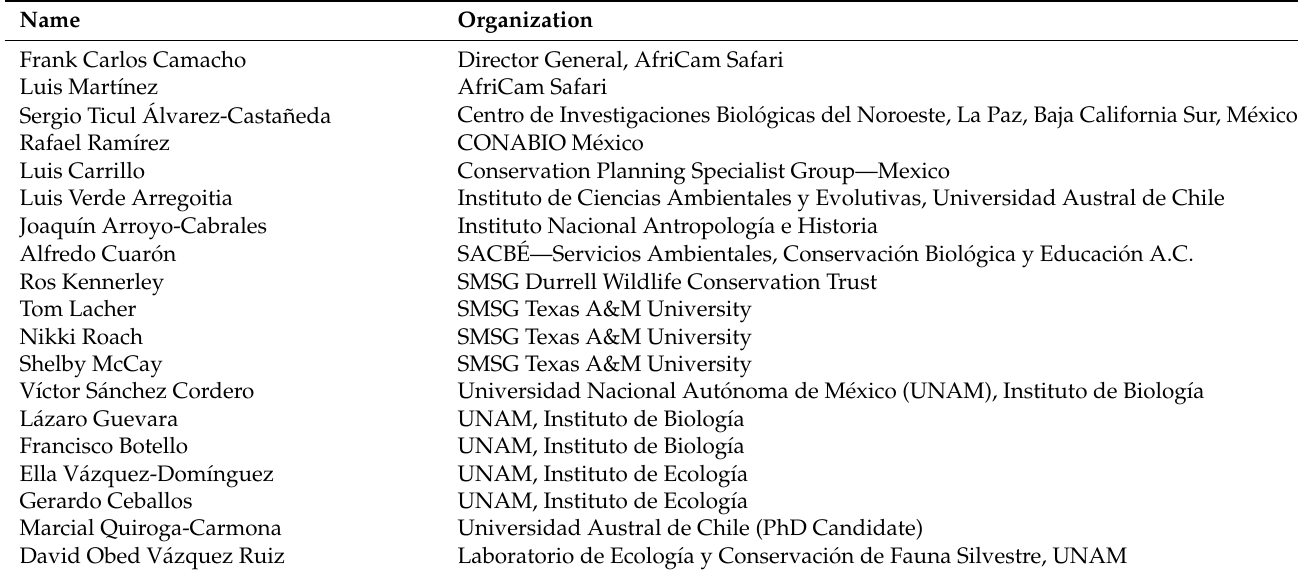
Table A1. Participants in SMSG Mexico workshop and workshop follow-up and institutional ties at the time of the workshop.